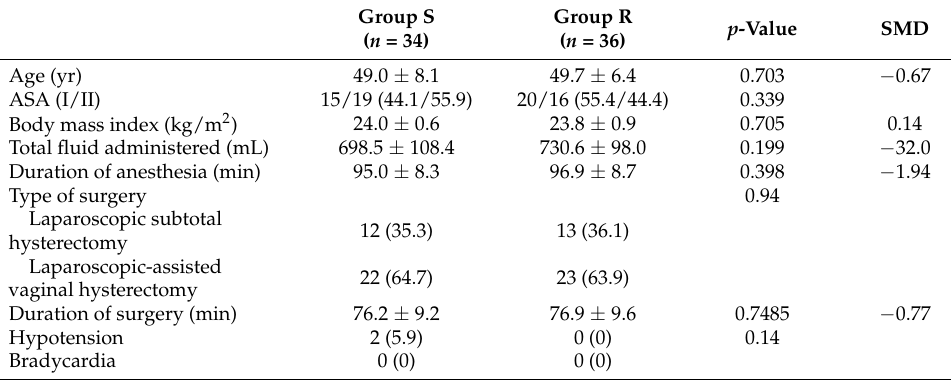
Table 1. Patients’ demographic and perioperative data.